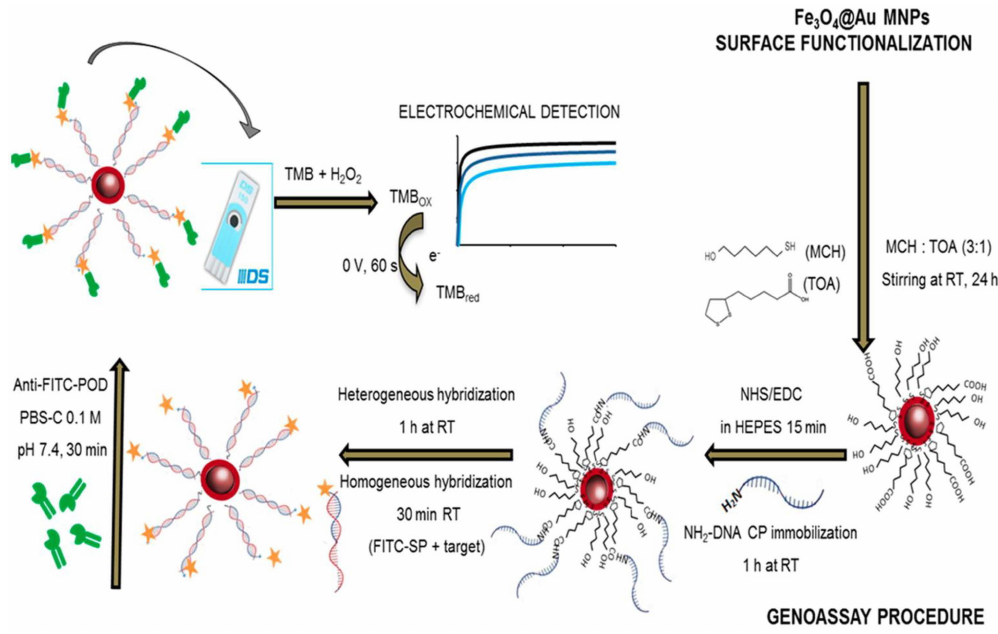
Figure 8. Scheme of the DNA electrochemical assay using Fe 3 O 4 @AuNPs for the detection of genetically modified organisms (GMOs). Adapted from Ref. [87] with